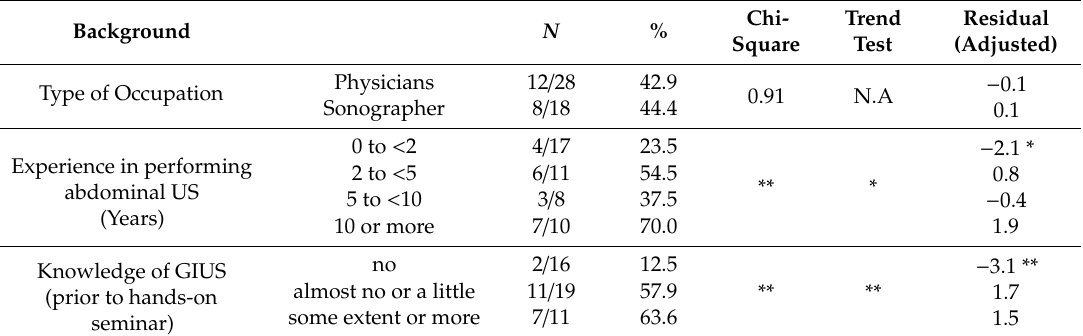
Table 3. Identifying any GI disorder two months after the hands-on seminar ( n = 46).